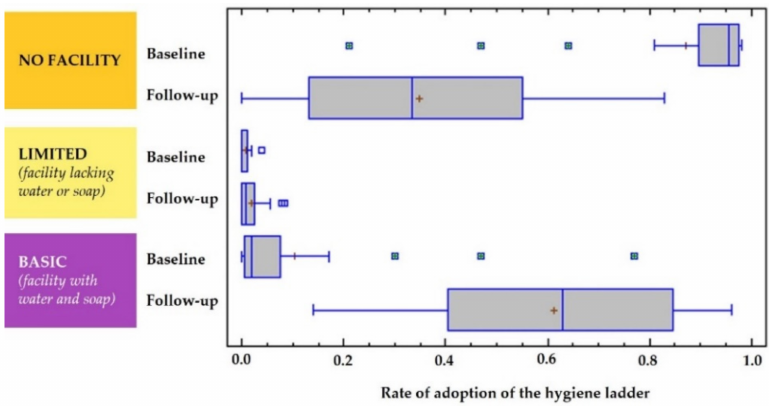
Figure 5. Box-and-whisker plot of the rate of adoption of the hygiene system in the Chamwino District before (baseline) and after (follow-up) the Programme. Data of the 241 subvillages